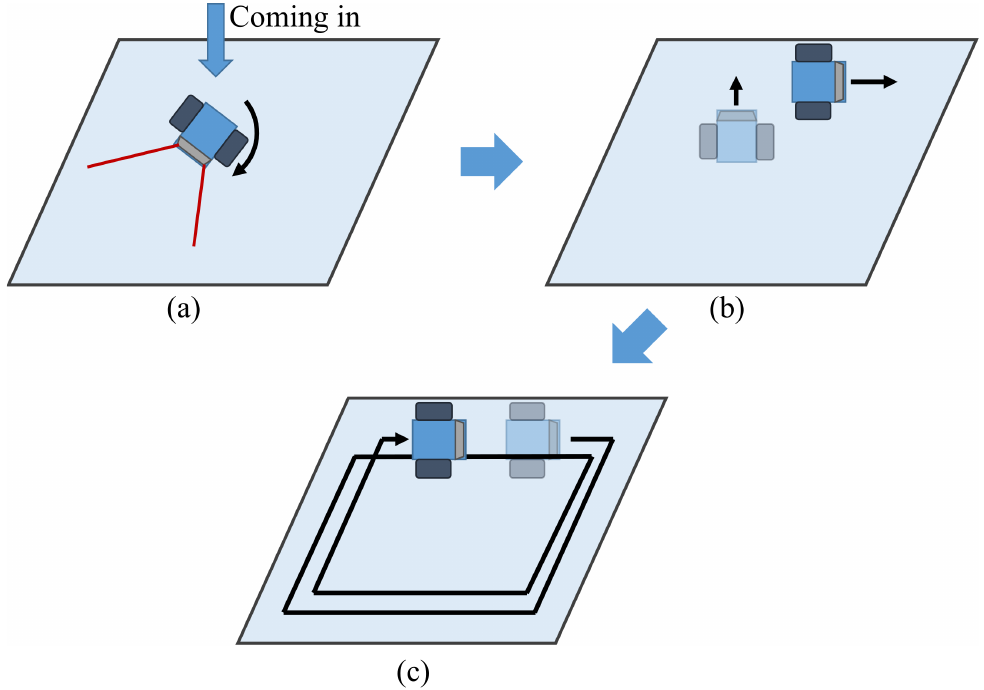
Figure 2. Exploration for the window shape estimation. ( a ) The scanning robot searches for a part of the window frame with an external sensor, turning at an initial point on the window the robot came in. ( b ) The robot gets close to the window frame and starts moving along the frame. ( c ) The robot goes around the same trajectory along the